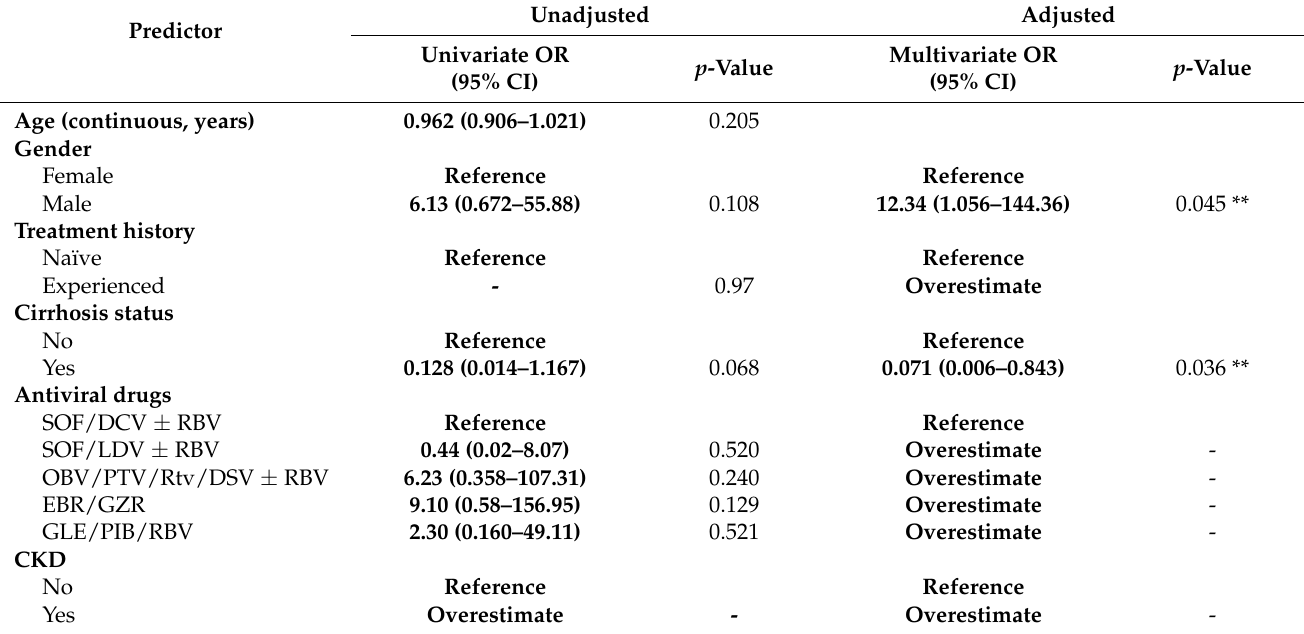
Table 5. Univariate and multivariate logistic regression analysis for predictors of